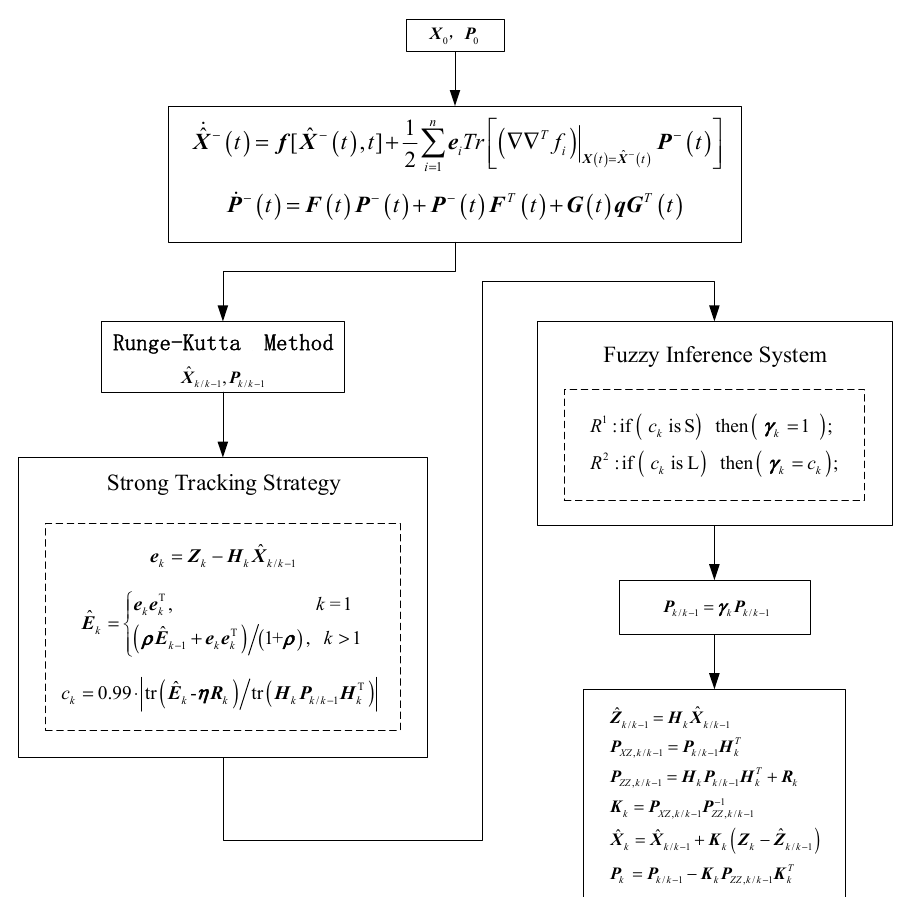
Figure 3. Flowchart of the second-order extended Kalman filter (EKF2) filter assisted by the adaptive fuzzy inference system (AFIS).